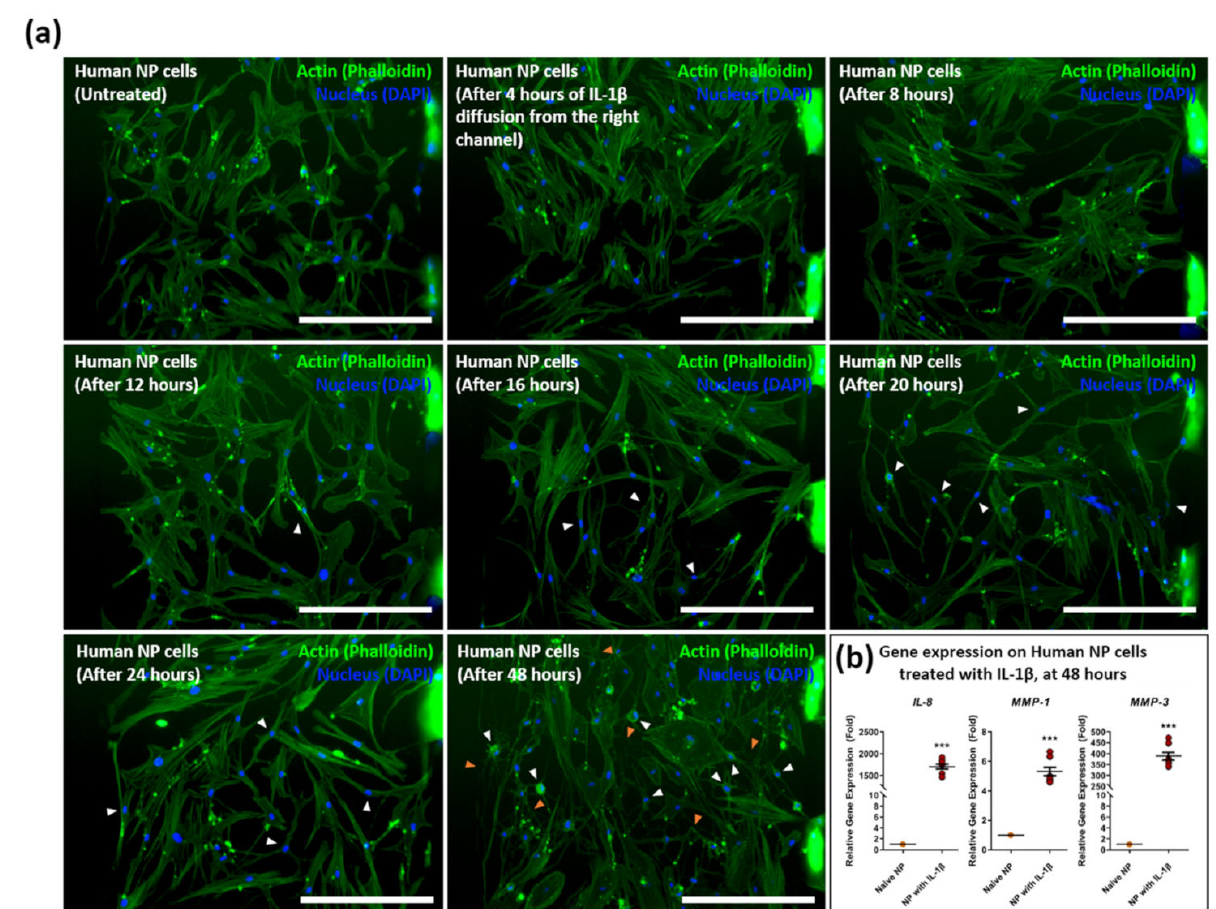
Figure 4. Diffusive stimulation of IL-1 β induces inflammatory morphological changes on human NP cells in the microfluidic chip. ( a ) Morphological changes on human NP cells were induced by the IL-1 β diffusion gradient from the right channel in a time-dependent manner. Human NP cells exposed to IL-1 β show filopodia and lamellipodia extension (orange arrowhead) and cytoplasm shrink (white arrowhead). ( b ) Gene expression of inflammatory mediators, including IL-8 , MMP-1 , and MMP-3 on human NP cells after 48 h of diffusion of IL-1 β . Each value is the mean ± standard error of five independent experiments. *** p < 0.0001 as compared with naïve NP. Scale bar = 400 µ m. Naïve NP; human NP cells cultured in absence of recombinant IL-1 β